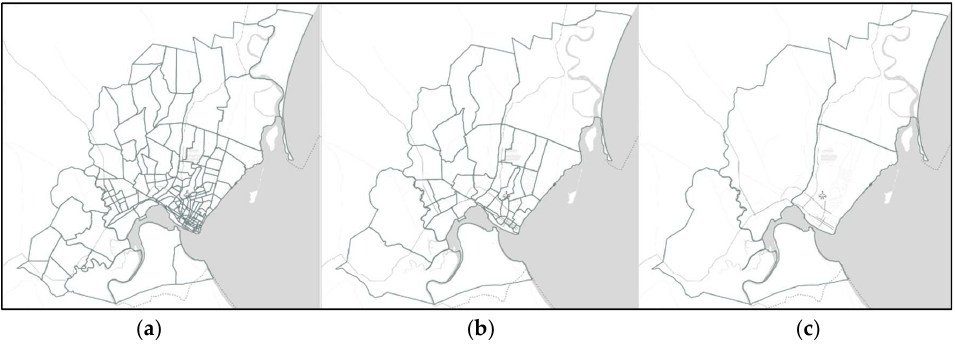
Figure 5. Division of traffic analysis zones (TAZs) for each TAZ level: ( a ) A TAZ, ( b ) B TAZ, and ( c ) C TAZ. Table 2. Statistical summary of Voronoi zones in the study area.